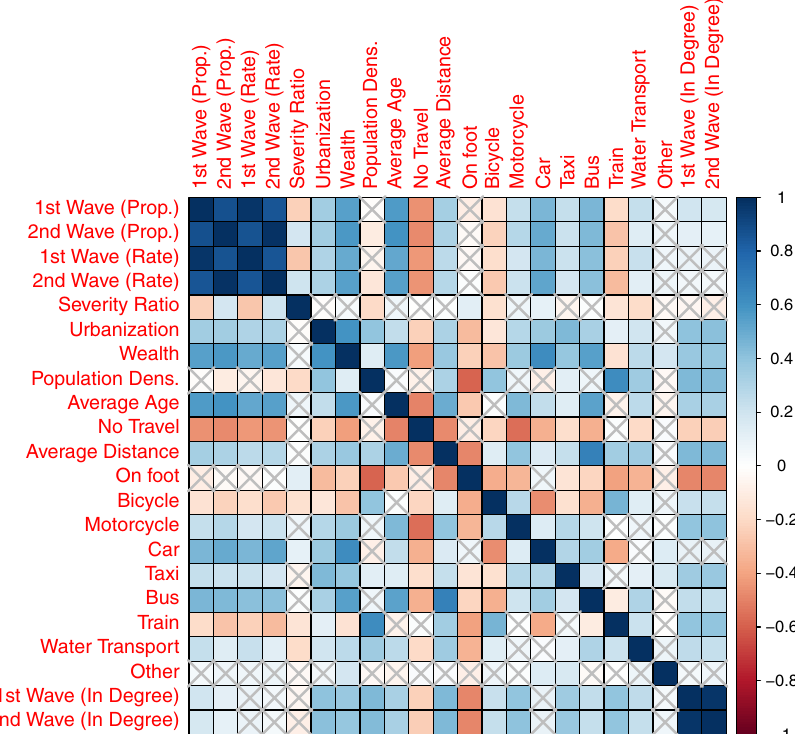
Fig. 3 Correlations between COVID-19 incidence metrics and relevant social, ecological, infrastructural, and urban form characteristics. Correlation matrix denoting Spearman ’ s correlation coef fi cients estimated for COVID incidence proportions and rates, severity ratio, urbanization, wealth (denoting living standards), population density, average age, commute to work variables, and in-degree estimates across districts ( n =